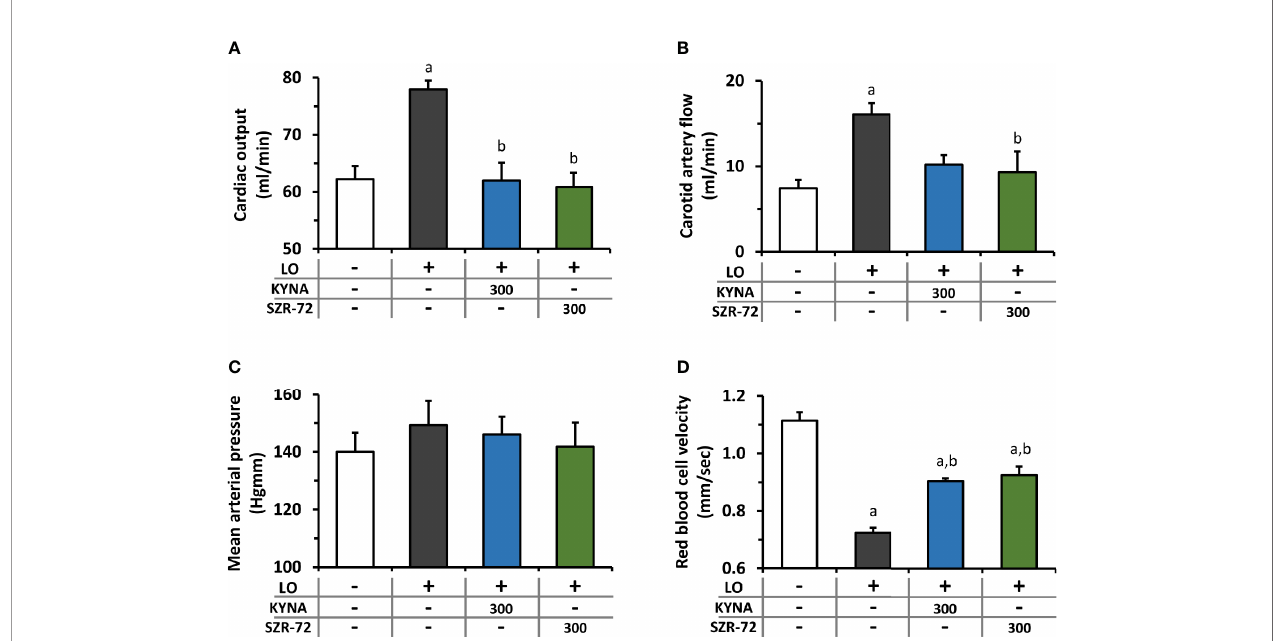
FIGURE 4 | Changes in circulation and haemodynamic parameters during experimental AP and treatments with KYNA and SZR-72. Bar charts show (A) cardiac output, (B) carotid artery fl ow (C) mean arterial pressure, and (D) red blood cell velocity. Values represent means with standard error, (A – C) n=3-6; (D) n=60-98. One-way ANOVA was performed followed by Holm-Sidak post-hoc test. Statistically signi fi cant differences (p<0.05) were marked with: (a) vs . control; (b) vs . LO. LO,